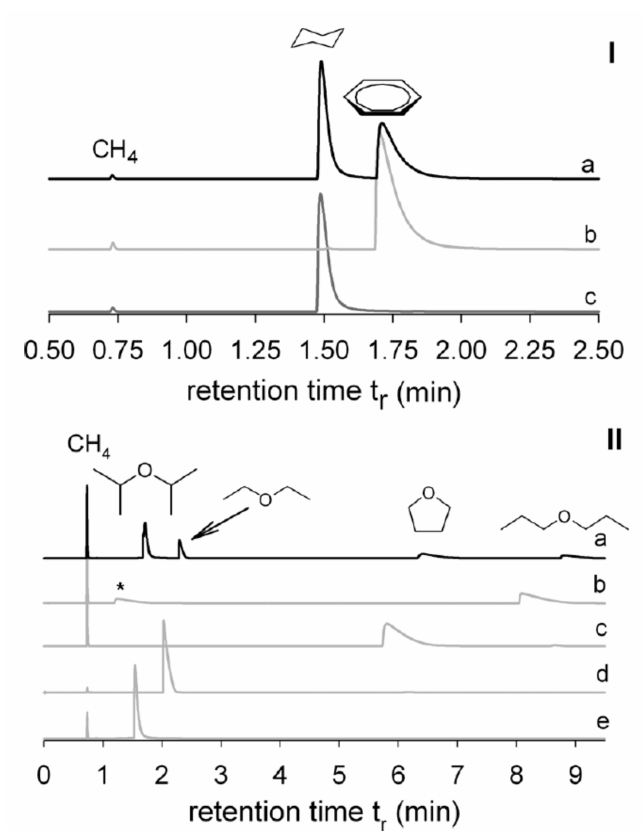
Figure 5. ( I ) Chromatographic separation of a mixture of methane (for the determination of the dead time in all chromatograms), cyclohexane, and benzene (a) pure benzene (b), and of pure cyclohexane (c). Experimental setup: column: HKUST-1@SiO 2 (30 m × 0.25 mm × 0.15 µ m); carrier: He, flow: 4.37 mL min − 1 , 76.2 cm s − 1 ; oven: 473.15 K, isotherm; injector: split, 11.7:1 at 250 ◦ C; detector: FID at 250 ◦ C. ( II ) Chromatographic separation of a mixture of methane, diisopropyl ether, diethyl ether, tetrahydrofuran, and di-n-propyl ether (black line) (a). Chromatograms of pure substances except methane. (b) Di-n-propyl ether. (c) Tetrahydrofuran. (d) Diethyl ether. (e) Diisopropyl ether. Experimental setup: column: HKUST-1@SiO 2 (30 m × 0.25 mm × 0.15 µ m); carrier: He, flow: 4.14 mL min − 1 , 72.5 cm s − 1 ; oven: 523.15 K, isotherm; injector: split, 12:1 at 250 ◦ C; detector: FID at 250 ◦ C. (*—impurity) [24]. Published by The Royal Society of